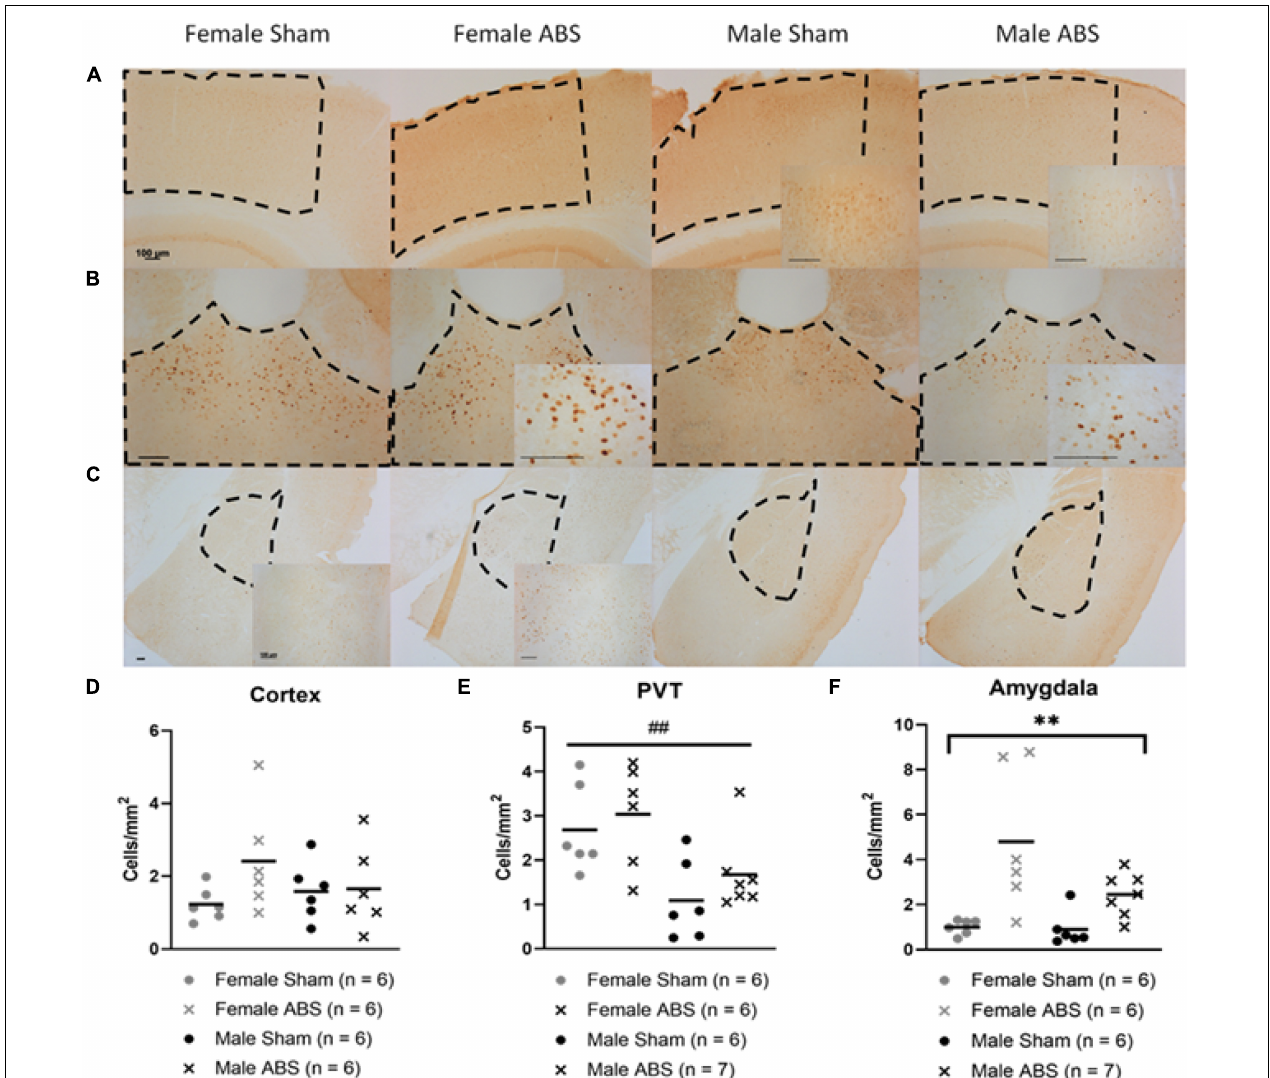
FIGURE 8 | c-Fos differences by sex and injury in the PVT and amygdala, respectively. Representative images of the (A) cerebral cortex, (B) PVT, and (C) amygdala (basolateral and central nucleus) with regions of interest outlined in dashed lines and magnified inserts of areas within the measured regions. All scale bars indicate 100 µ m. (D) The cerebral cortex did not show any significant difference between injury or sex. (E) The PVT displayed an overall effect of sex in which females had more c-Fos positive cells compared to males. (F) There was a main effect of injury in the amygdala, where injured mice had greater c-Fos cell density than sham mice. Bars indicate means. ## indicates main effect of sex p ≤ 0.001, ∗∗ indicates main effect of injury p ≤